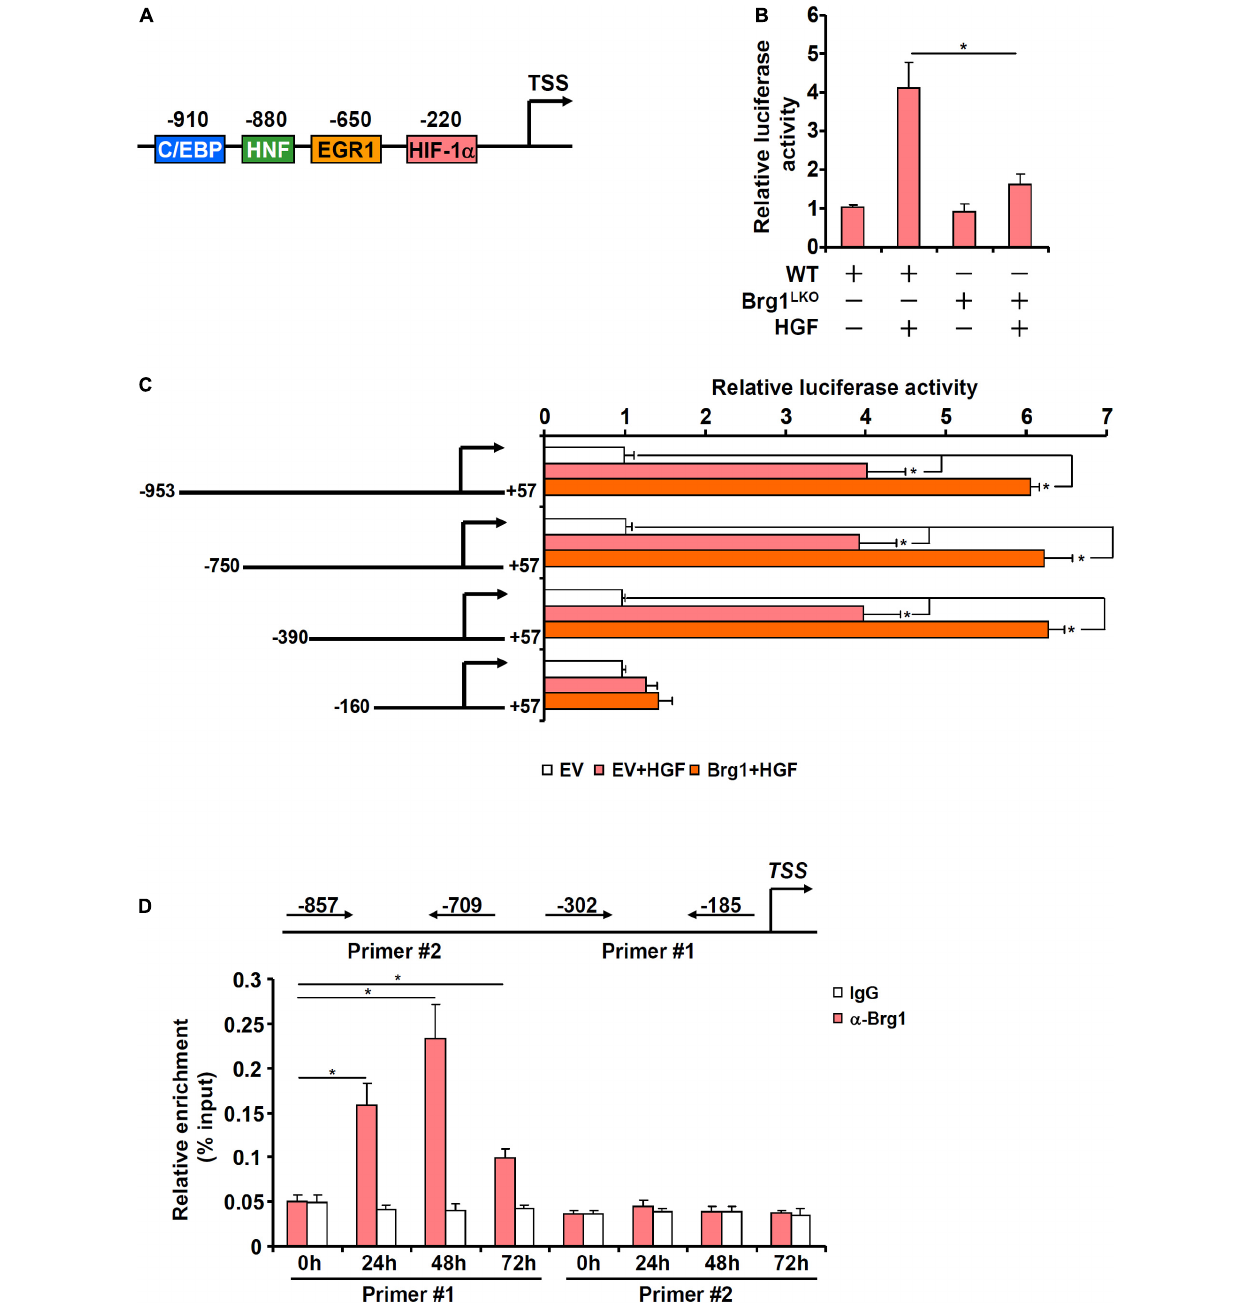
FIGURE 4 | Brahma-related gene 1 contributes to Chka transcription in hepatocytes. (A) Schematic representation of the mouse Chka proximal promoter. TSS, transcription start site; HIF-1 α , hypoxia induced factor 1; EGR1, early growth response 1; HNF, hepatocyte nuclear factor; C/EBP, CCAAT enhancer binding protein. (B) A Chka promoter-luciferase construct was transfected into primary hepatocytes isolated from WT and Brg1 LKO mice followed by HGF treatment. Luciferase activities were normalized by protein concentration and GFP fluorescence. (C) Chka promoter-luciferase constructs were transfected into primary hepatocytes with or without Brg1 followed by treatment with HGF. Luciferase activities were normalized by protein concentration and GFP fluorescence. (D) Primary murine hepatocytes were treated with HGF and harvested at indicated time points. ChIP assay was performed with anti-Brg1 or IgG. * p <